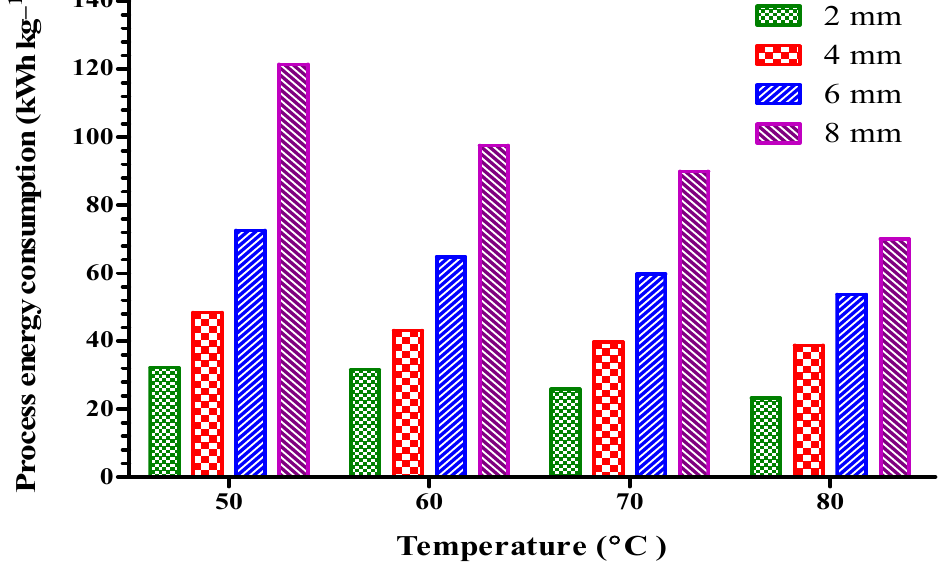
Figure 4. Process energy consumption of plantain banana slices during convective hot air drying at different temperatures and thicknesses.